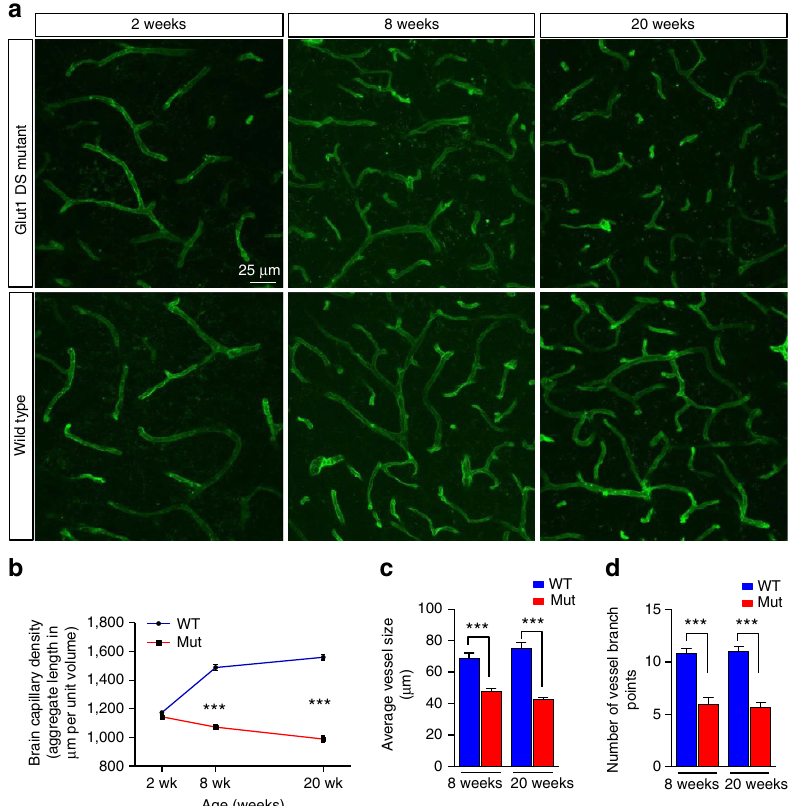
Figure 1 | Cerebral microvasculature defects in Glut1 DS. ( a ) Thalamic sections of Glut1 DS model mice and littermate controls stained with labelled lectin reveal cerebral angiogenesis defects and diminution of the microvasculature of mutants at 8 and 20 weeks of life. Graphs quantifying ( b ) aggregate cerebral capillary length, ( c ) mean vessel size and ( d ) average capillary branches in the mutants and controls illustrate the diminished size of the microvasculature in adult Glut1 DS mice. ***, P o 0.001, t -test, n Z 9 regions from each of N Z 3 mice of each genotype